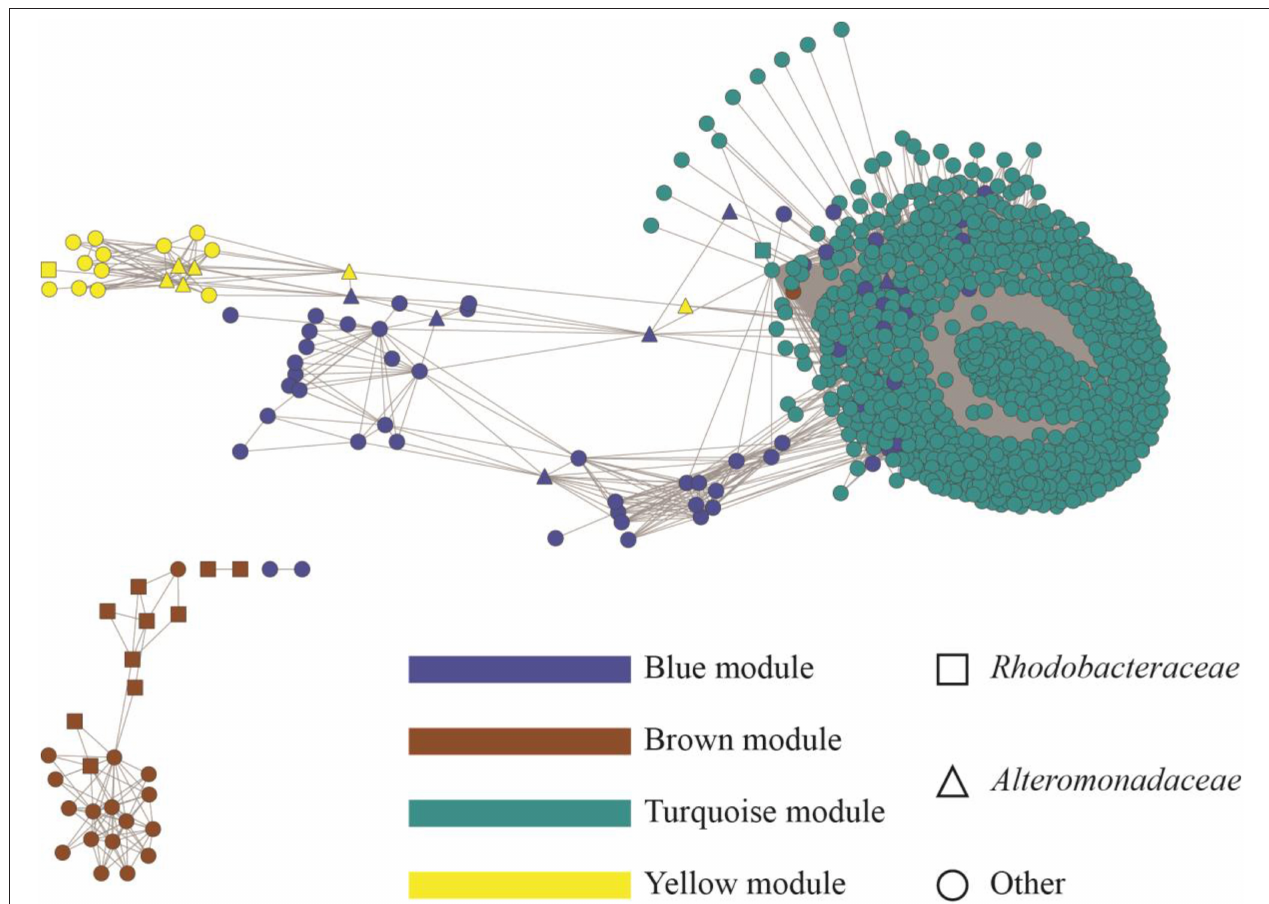
FIGURE 4 | Topology of the microbial community associated with N. salina . The identified modules were colored according to module names (Blue, Brown, Turquoise, and Yellow). The whole network contains 1000 nodes representing bacterial OTUs and 68,675 edges, showing correlations between the OTUs with an edge weight cutoff of 0.20 in the WGCNA network ( DiLeo et al., 2011). OTUs were annotated at the family level. Rhodobacteraceae and Alteromonadaceae are shown as squares and triangles, respectively. OTUs from families other than Rhodobacteraceae and Alteromonadaceae are displayed as